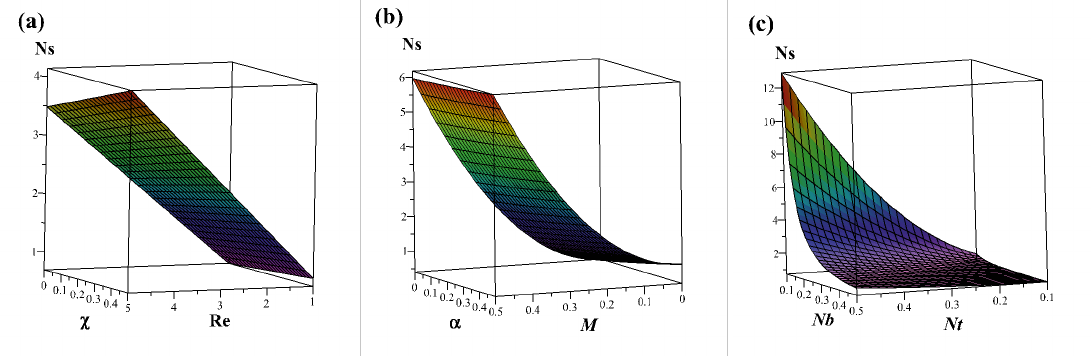
Fig. 8: Combined effects of physical parameters on entropy generation